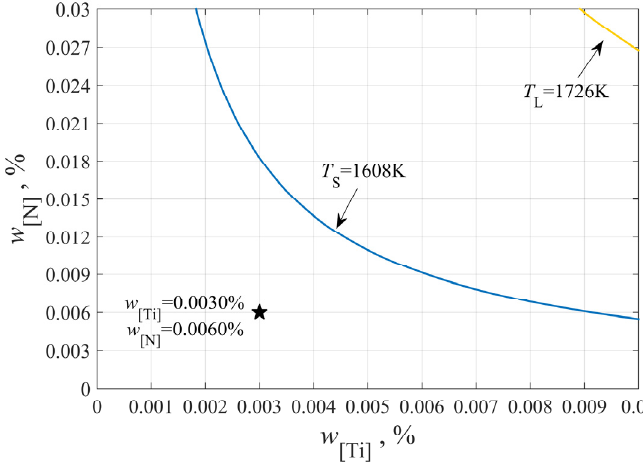
Figure 1. The stability diagram of TiN inclusions precipitation.